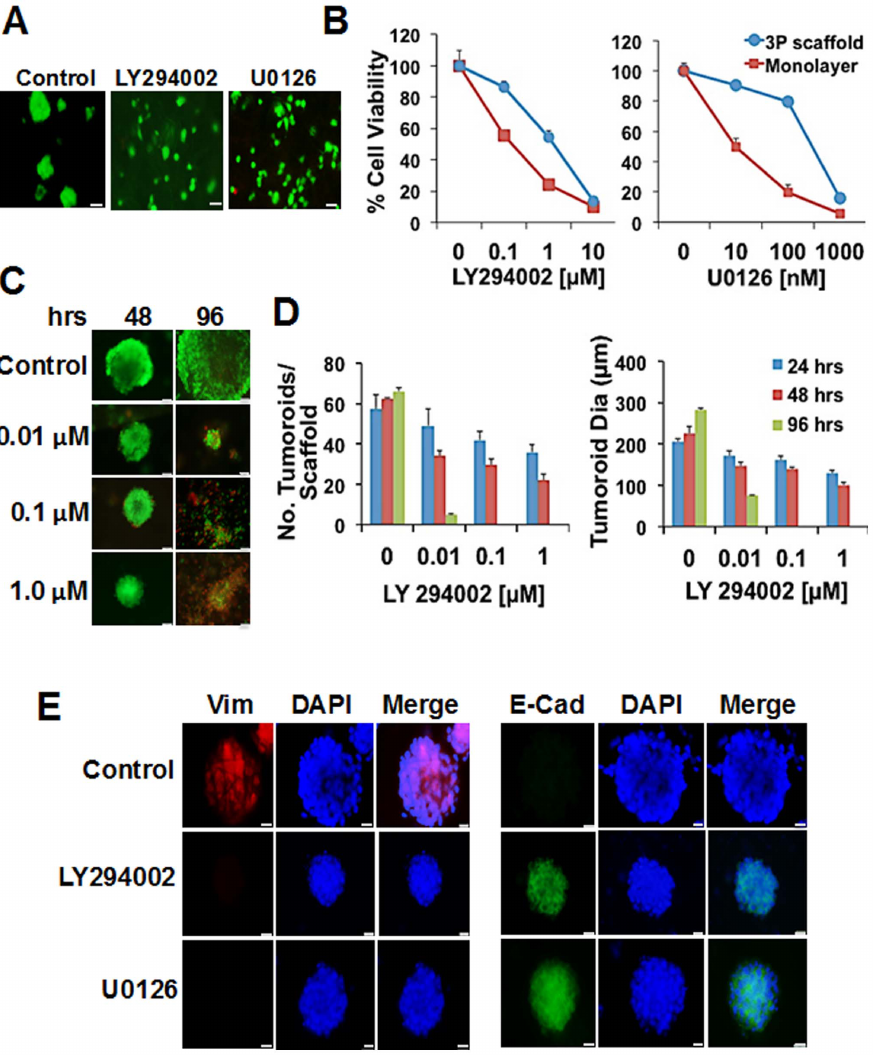
Figure 5. Altered sensitivity of tumoroids to EMT specific inhibitors. (A) The PI-3K inhibitor (LY294002) and MAPK inhibitor (U0126) prevented MCF7 tumoroid formation on 3P scaffold. Scale bar=50 m m. (B) Dose-dependent cytotoxic response of MCF7 cells cultured on the 3P scaffold vs. monolayer. (C–D) Inhibitors induced cell death in LLC1 tumoroids. LLC1 tumoroids (day 4) were exposed to various concentrations of LY29400 for the indicated days and then stained with calcein AM/EthD-1 and observed for changes in tumoroid size and numbers. Four scaffolds/ time point and 5 tumoroids/scaffold examined. The experiments were repeated in triplicates and data presented as mean 6 SD. * p , 0.05. Scale bar=50 m m. (E) Abrogation of EMT in LLC1 tumoroids treated with inhibitors. Cells were fixed and immunostained using anti-E- cadherin (green), anti-vimentin (red) and DAPI (blue). Scale bar=20 m m.